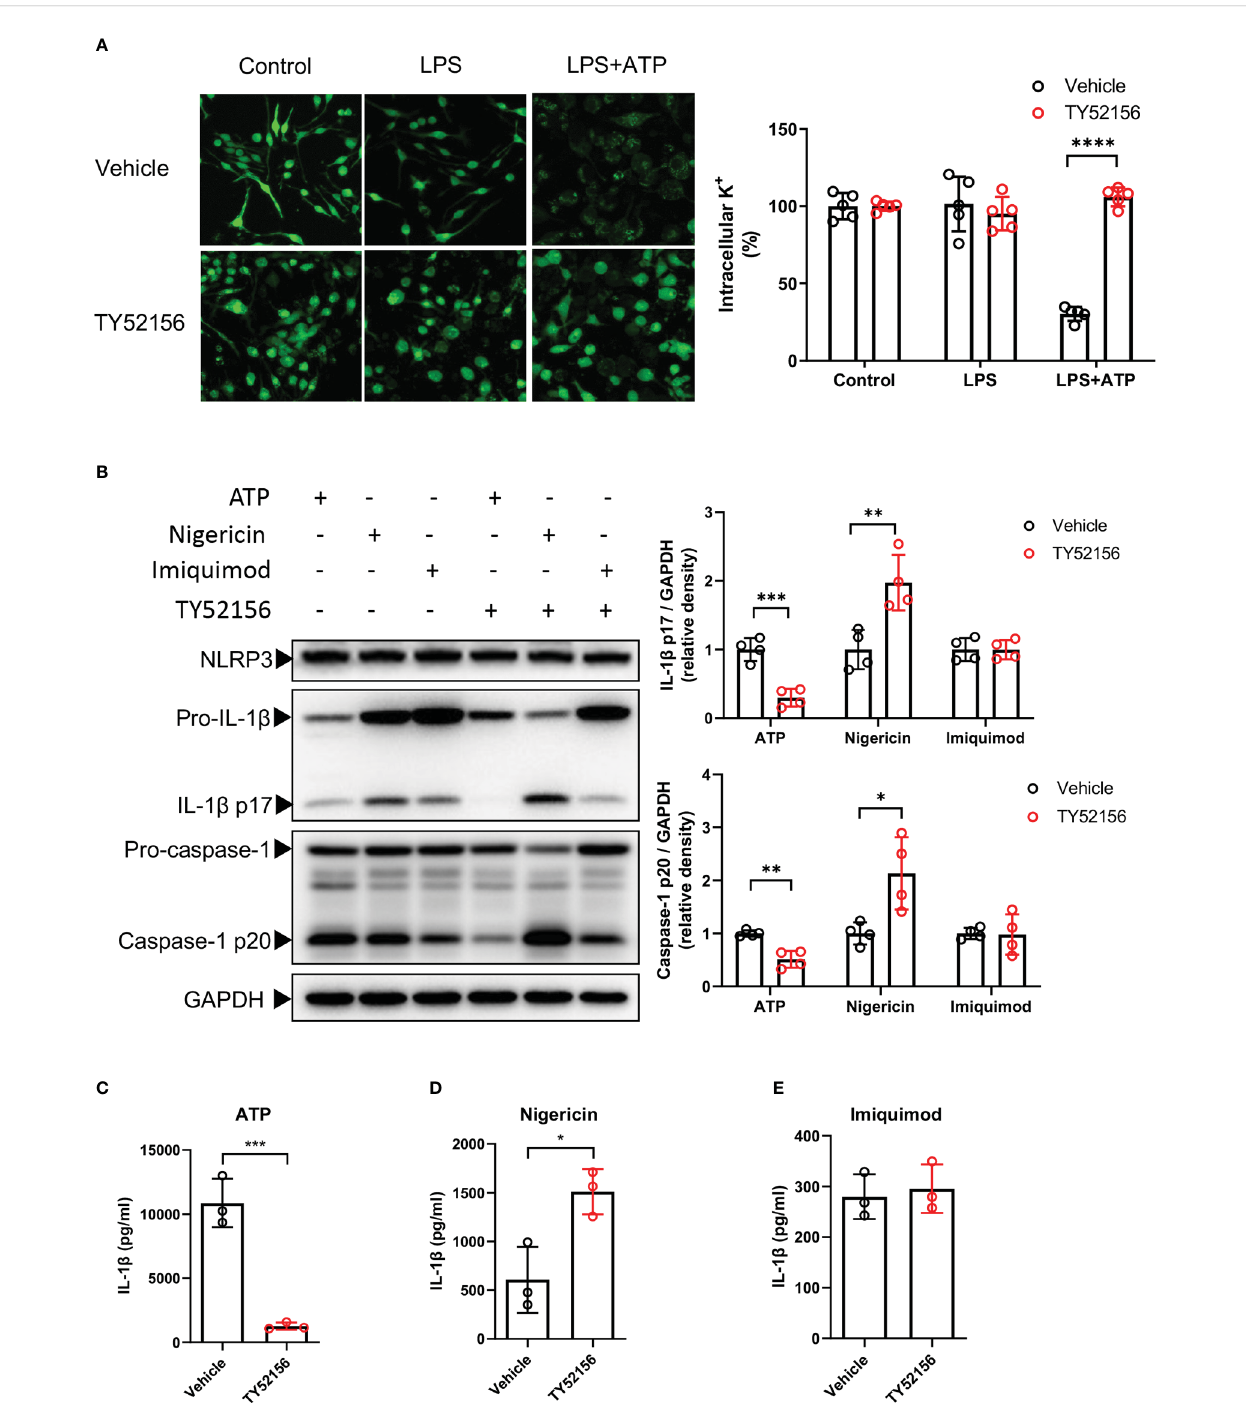
FIGURE 4 Inhibition of S1PR3 suppresses ATP-induced NLRP3 in fl ammasome activation via potassium ef fl ux. (A) BMDMs were primed with LPS (1 m g/mL) and treated with TY52156 (10 m M) or vehicle for 3.5h, followed by ATP (3mM) stimulation for 30 min. Representative intracellular potassium fl uorescence image of 5 fi elds from 3 independent experiments. Values are presented as mean ± SD. ****p < 0.0001, two-tailed t-test. (B-E) BMDMs were primed with LPS (1 m g/mL) and treated with TY52156 (10 m M) or vehicle for 3.5h, followed by ATP (3mM), nigericin (10 m M), or imiquimod (25 m g/mL) stimulation for 30 min. Pro-IL-1 b , IL-1 b p17, pro-caspase-1, and caspase-1 p20 in BMDMs were measured by Western blot (n= 4) (B) . IL-1 b in the supernatant was measured by ELISA (n= 3) (C-E) . Values are presented as mean ± SD. *p < 0.05, **p < 0.01, ***p < 0.001, two-tailed